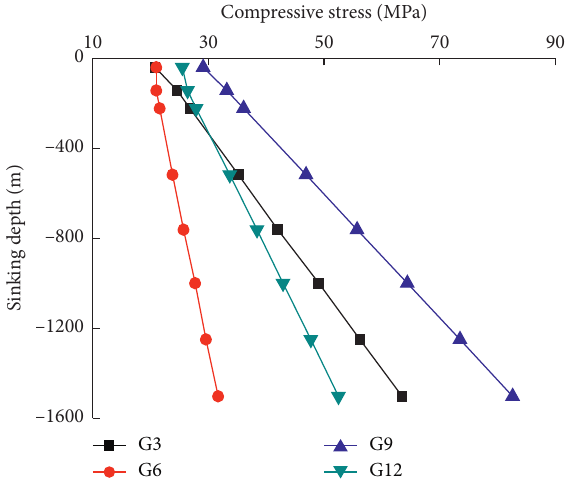
Figure 6: The theoretical stress curve of middle corner columns under different working conditions.